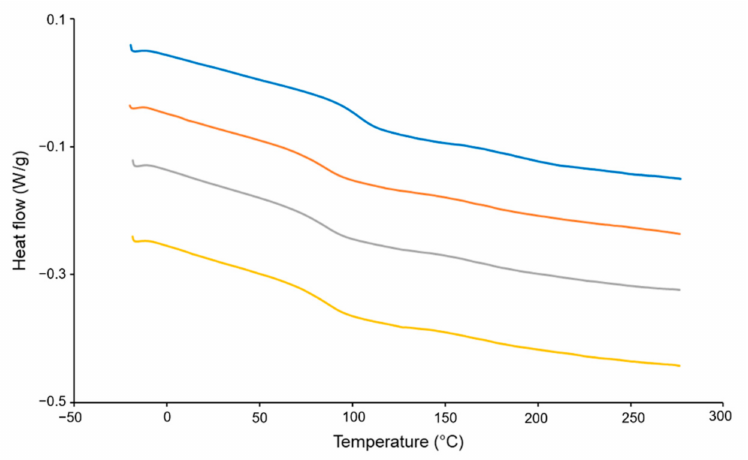
Figure 7. DSC results of HPMC, physical mixture, filament and 3D-printed shell of the